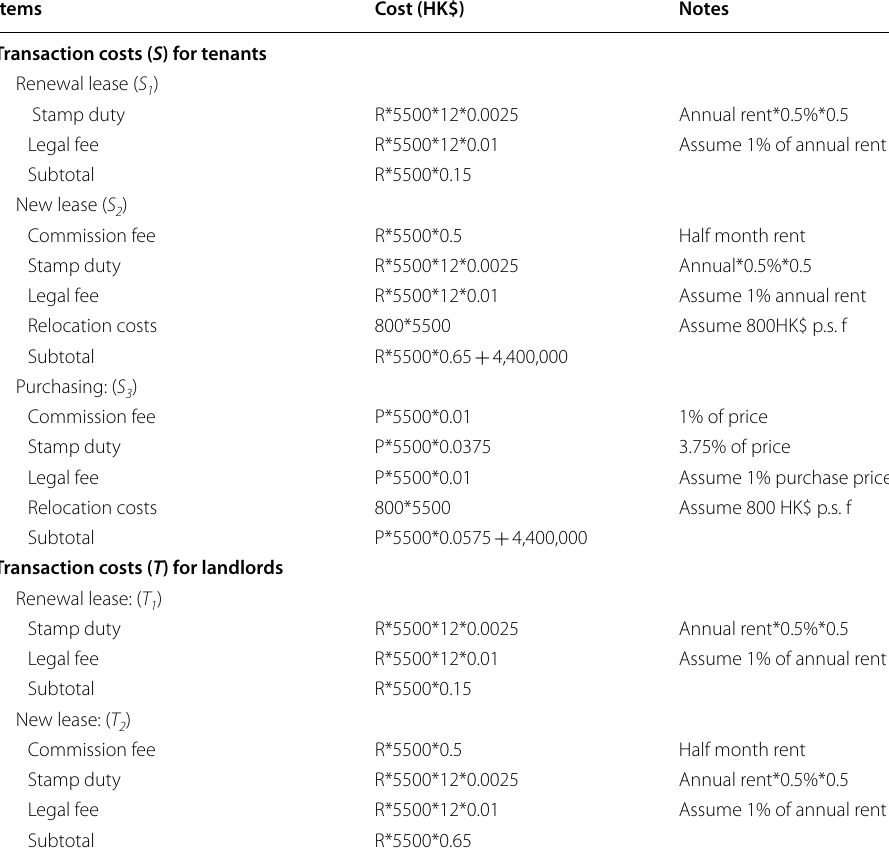
Table 4 Calculation of transaction